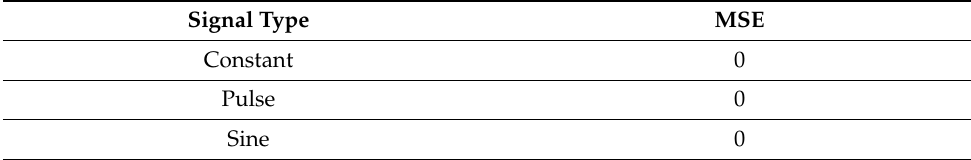
Figure 17. The outputs of 80 correlation lags of a sine signal with the amplitude of 31 and the period of 4000 data points from the multi-tau FPGA correlator and the software correlator. The correlation lag doubles every 8 lags after the initial 16 lags. Table 3 is the MSE between the FPGA multi-tau correlator and the software multi-tau correlator. The MSE of zero demonstrated both outputs were identical. Table 3. MSE of the multi-tau correlator.